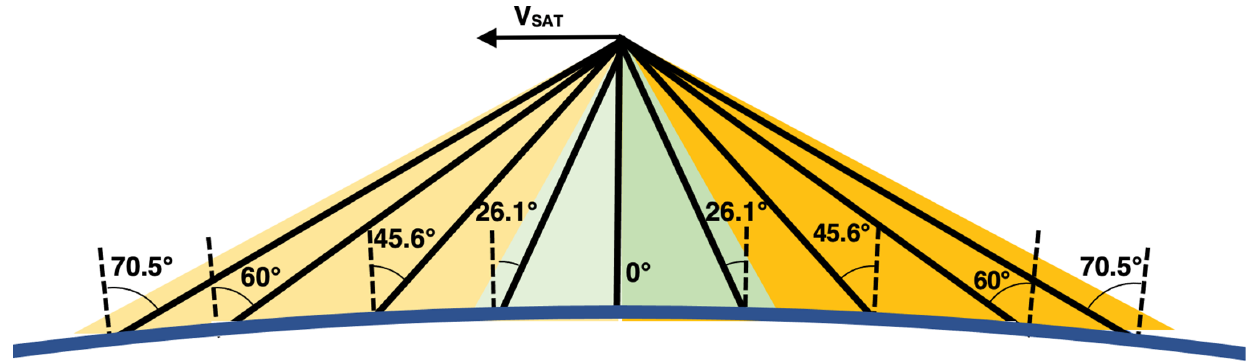
Figure 5. Schematic representation of NASA-JPL MISR view angles, all within the view-angle range reached by HORUS (not to scale). Table 2. Off-nadir angles corresponding to the view angle of 70.5 ◦ at various orbital